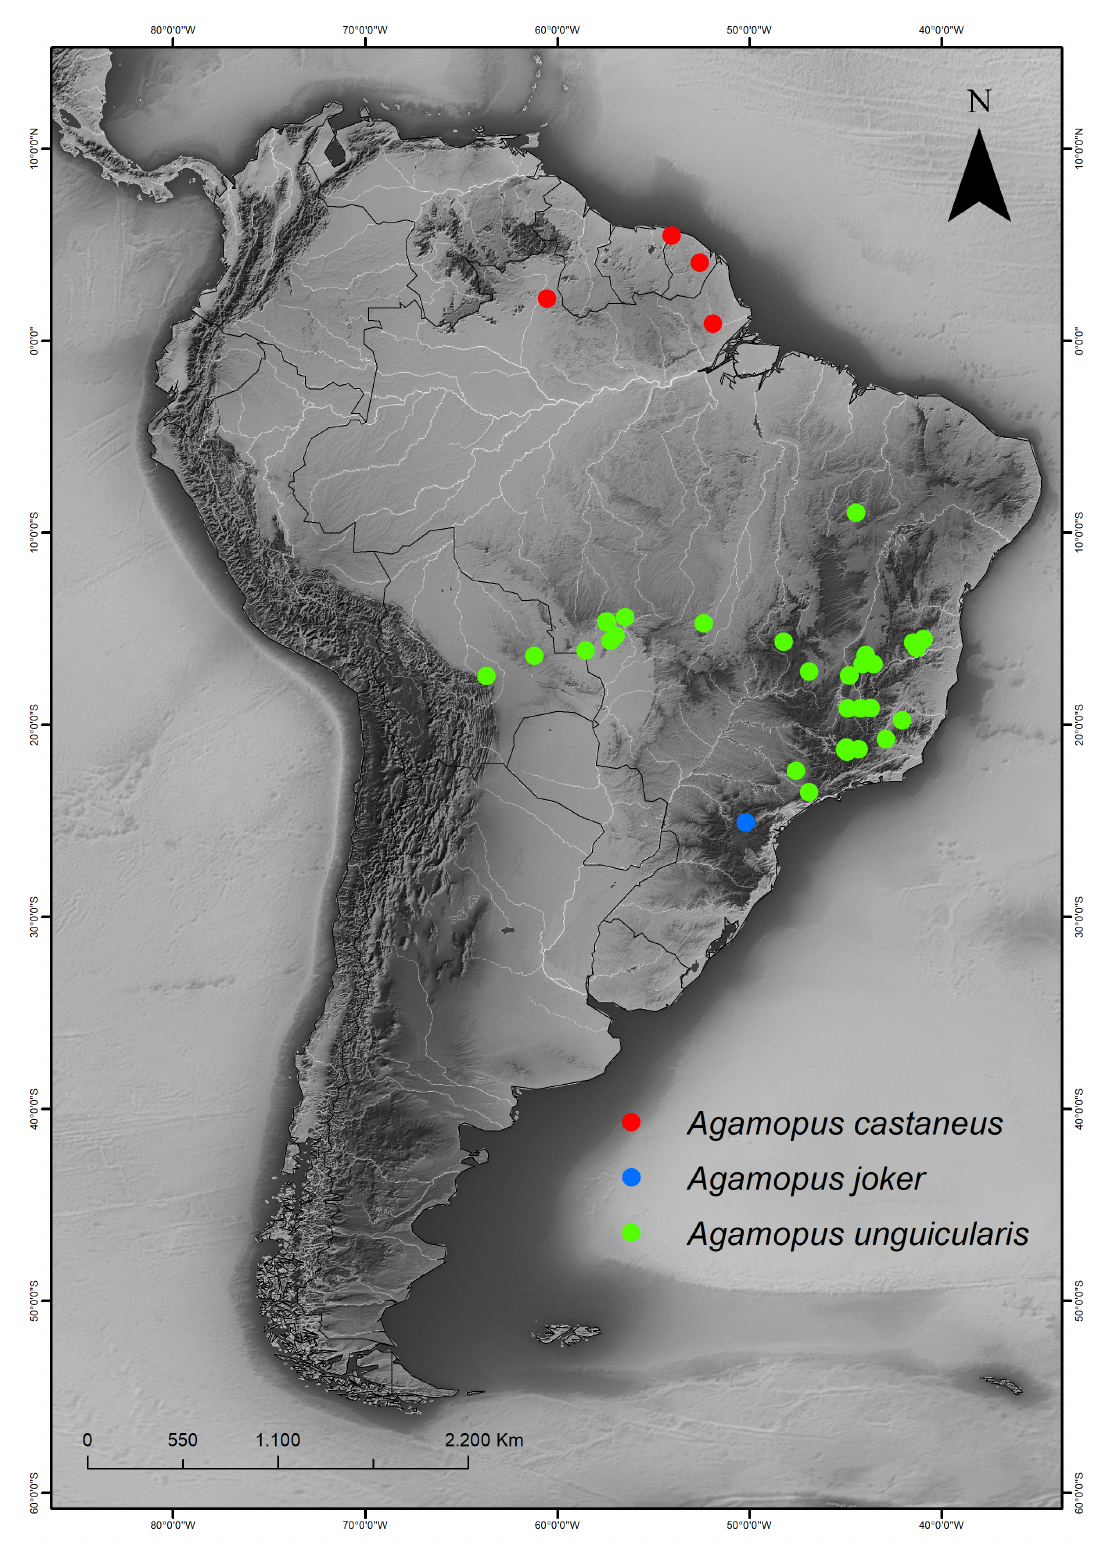
Fig. 3. Geographical distribution map of Agamopus joker sp. nov. (blue circle); A . unguicularis (Harold, 1883) (green circles); and A . castaneus Balthasar, 1938 (red